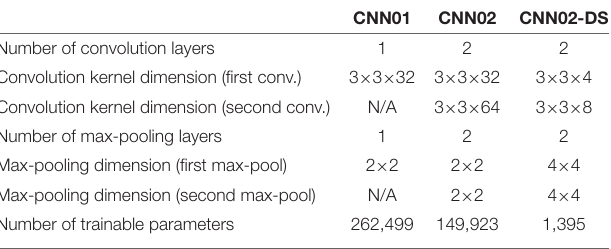
TABLE 6 | Scanning range and granularity of the hyperparameters explored during automated network optimization using KerasTuner.